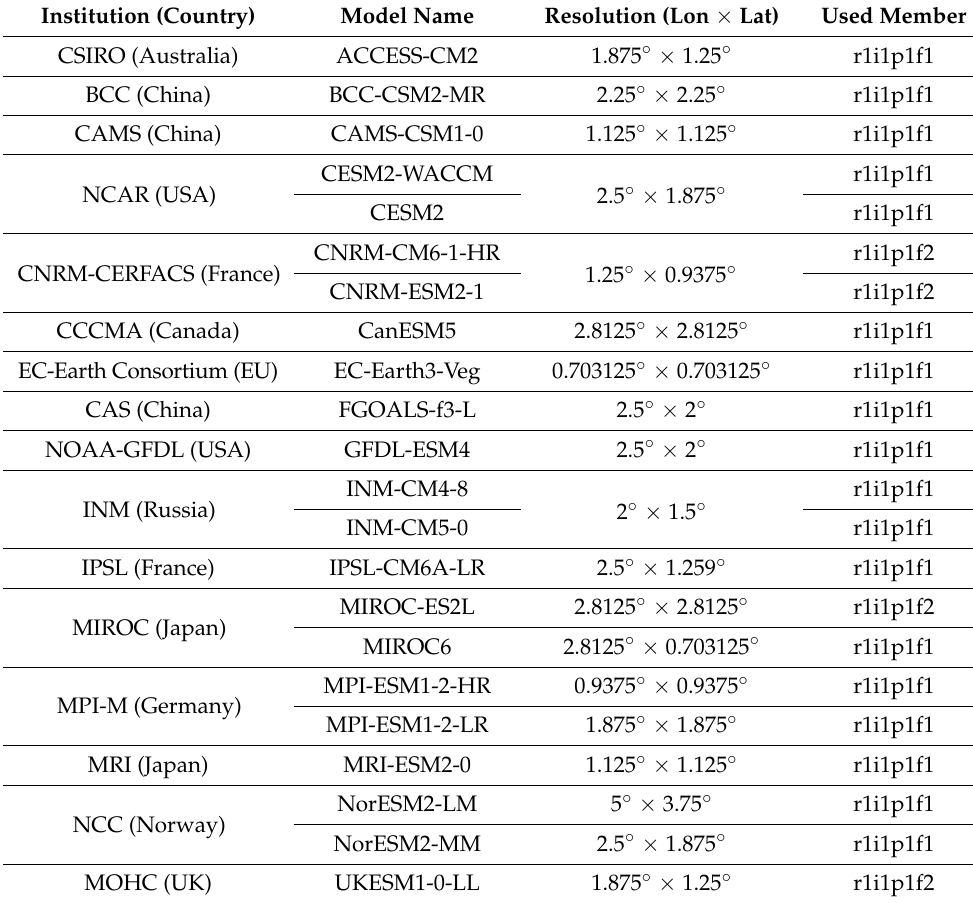
Table 1. GCM and their grid size resolutions used in the current